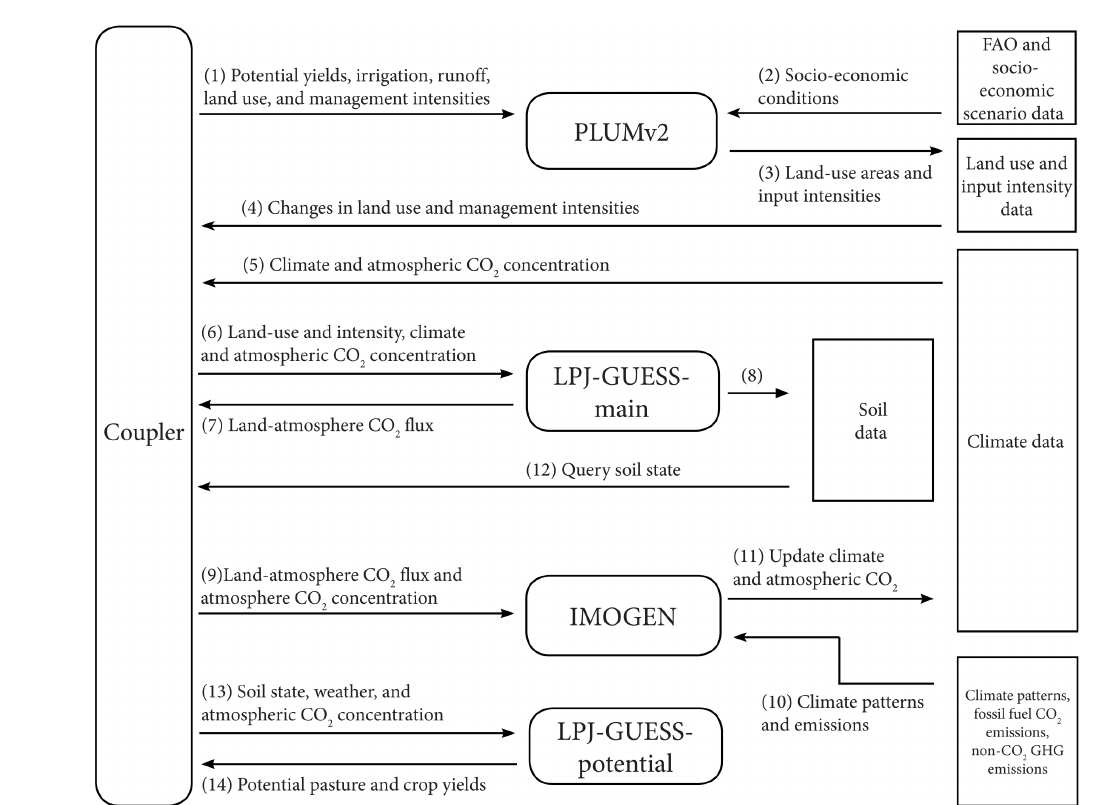
Figure 5. LPJ-GUESS, IMOGEN, and PLUMv2 model coupling structure and feedback between models and data. Numbers indicate se- quence of steps after initialization. (8) LPJ-GUESS-main modifies the soil state locational data.